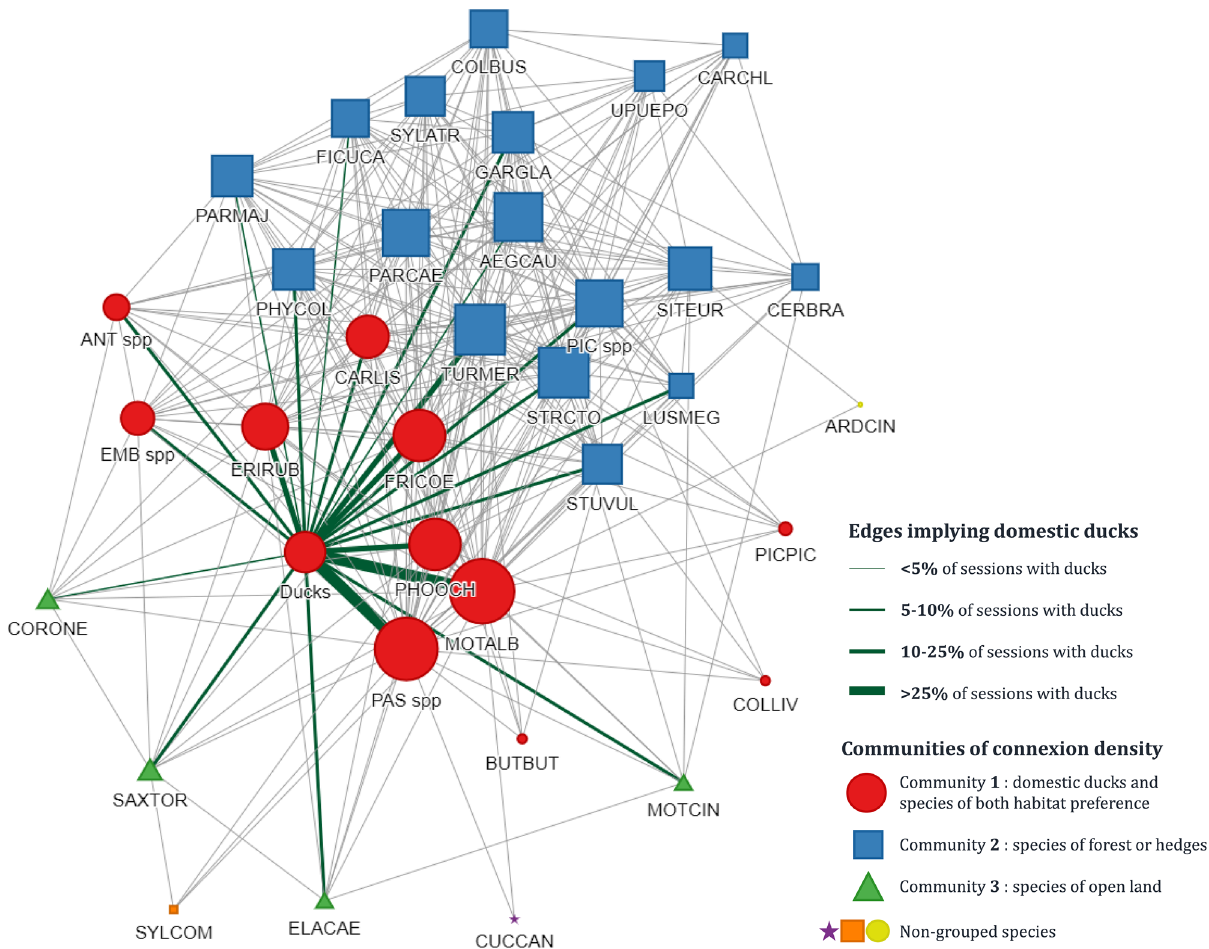
Figure 4. Undirected weighted network based on 87 observation sessions on duck foraging areas, leading to 1761 individual observations of 36 species or groups of species. Nodes are each species (or group), edges are observed interactions (co-occurrence) between two species. Nodes are coloured and shaped by community and sized by degree (number of contact-species), and arranged to show the most connexions as possible. Interactions with ducks are highlighted in green. Edge thickness is relative to their weight, i.e. their relative frequency in the total number of observation sessions. Species names are coded as follows: Ducks: Domestic ducks; AEGCAU: Aegithalos caudatus ; ANT spp: Anthus spp .;ARDCIN: Ardea cinerea ; BUTBUT: Buteo buteo ; CARCHL: Chloris chloris ; CARLIS: Carduelis carduelis ; CERBRA: Certhia brachydactyla ; COLBUS: Columba palumbus ; COLLIV: Columba livia ; CORONE: Corvus corone ; CUCCAN: Cuculus canorus ; ELACAE: Elanus caeruleus ; EMB spp: Emberiza spp .; ERIRUB: Erithacus rubecula ; FICUCA: Ficedula hypoleuca ; FRICOE: Fringilla coelebs ; GARGLA: Garrulus glandarius ; LUSMEG: Luscinia megarhynchos ; MOTALB: Motacilla alba ; MOTCIN: Motacilla cinerea ; PARCAE: Cyanistes caeruleus ; PARMAJ: Parus major ; PAS spp.: Passer domesticus & P. montanus ; PHOOCH: Phoenicurus ochruros ; PHYCOL: Phylloscopus collybita ; PIC spp.: Picidae ; PICPIC: Pica pica ; SAXTOR: Saxicola rubicola ; SITEUR: Sitta europea ; STRCTO: Streptopelia decaocto ; STUVUL: Sturnus vulgaris ; SYLATR: Sylvia atricapilla ; SYLCOM: Sylvia communis ; TURMER: Turdus merula ; UPUEPO: Upupa epops